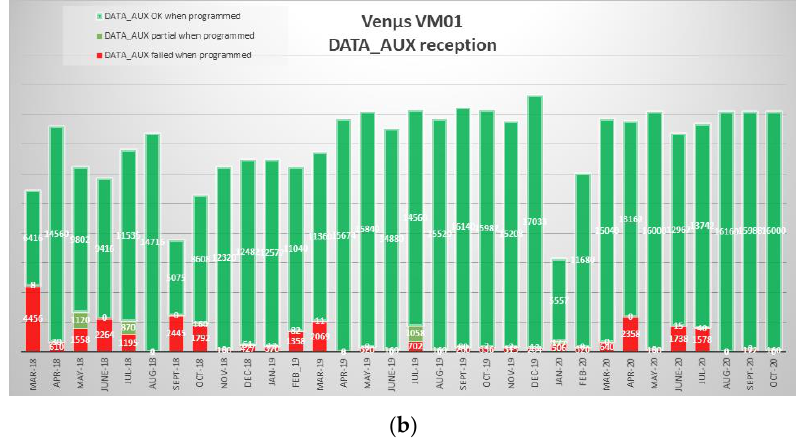
Figure 42. ( a ) Statistics on image telemetry completeness; ( b ) statistics on auxiliary data completeness. Two units of the SMIGS Center are in charge of processing VEN µ S